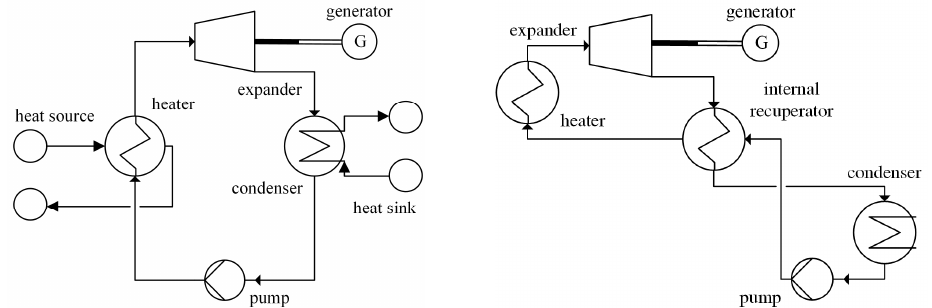
Figure 2. Scheme of Organic Rankine Cycle plant ( left : basic ORC with heat source and heat sink; right : ORC including internal recuperator (heat source and sink aren’t shown for clarity reasons)).